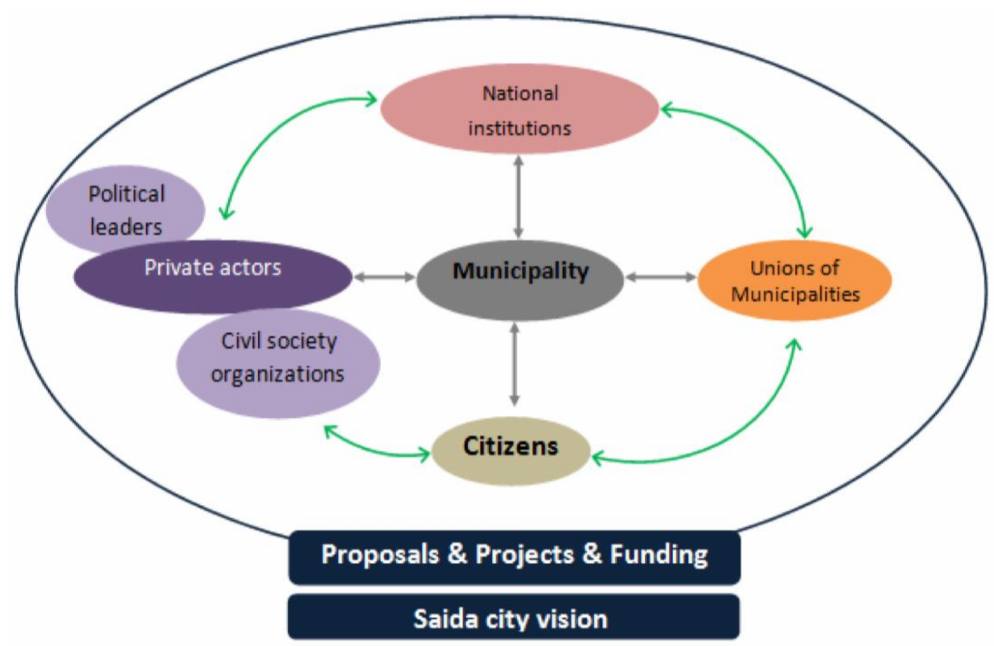
Figure 3. The decision-making process cycle that needs to be instituted to strengthen urban governance